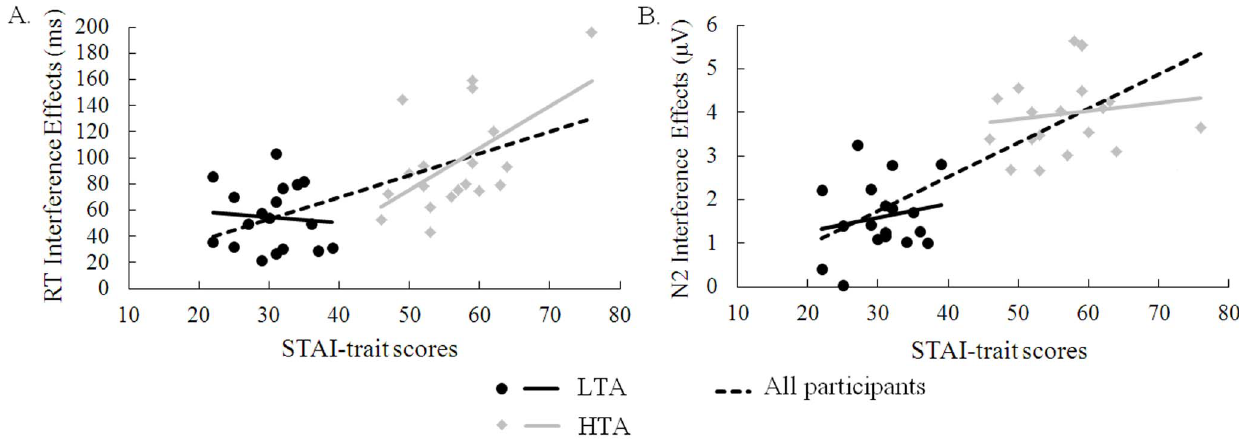
Figure 5. Scatterplots of the relationship between trait anxiety (TA) scores and interference effects (i.e., incongruent-congruent) on reaction times (RTs) (A) and N2 mean amplitudes (B) under high WM load. STAI = State-Trait Anxiety Inventory. Note that here the inverse of N2 amplitude data was used for correlations.